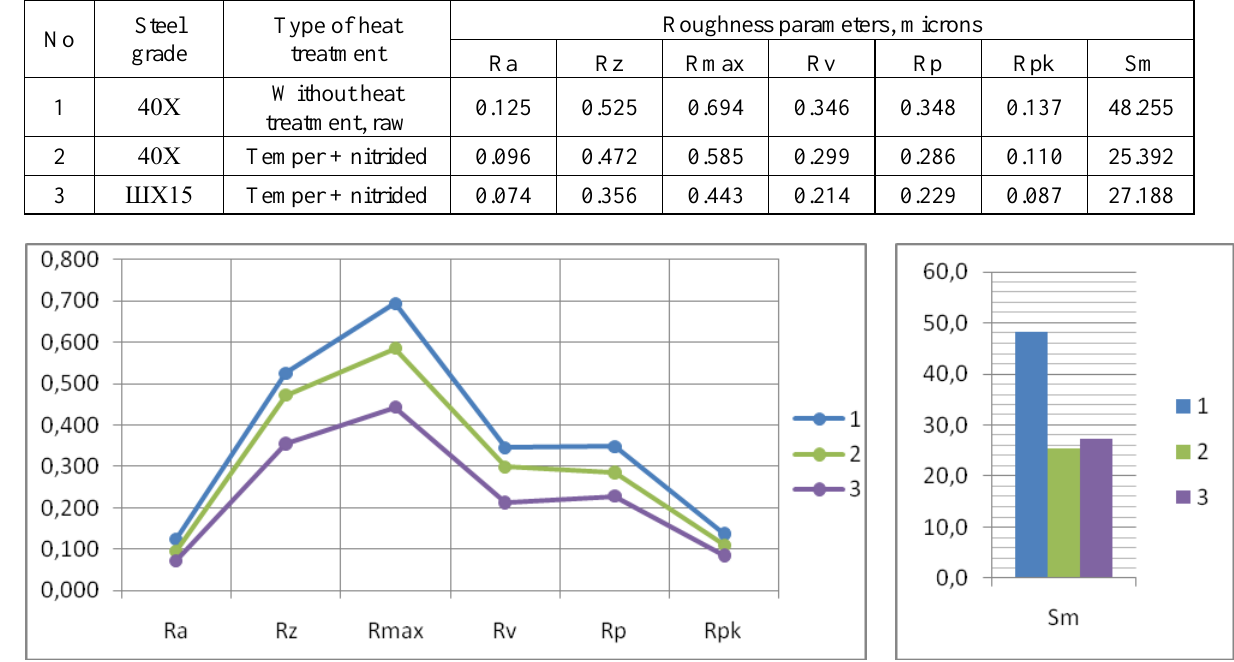
Parameters of the investigated roughness along the raceway.